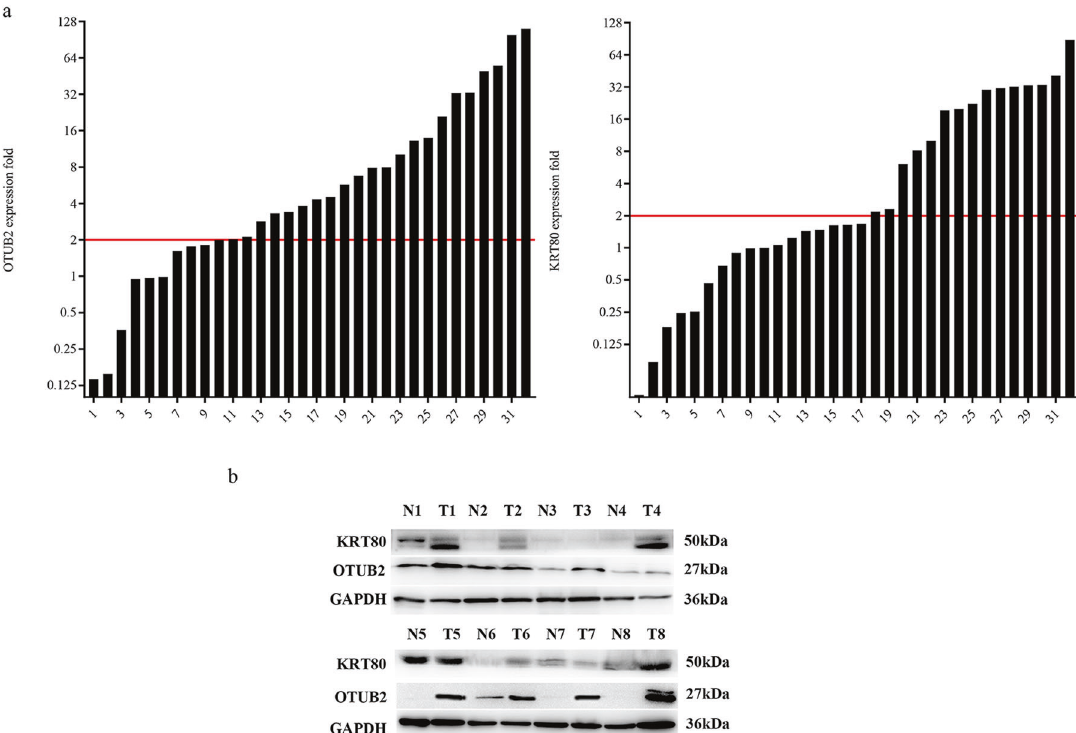
Fig. 1 OTUB2 and KRT80 are expressed in gastric cancer tissues. a Real-time PCR analysis of the expression of OTUB2 and KRT80 in 32 primary gastric cancer tissues and paired normal tissues. The levels of mRNA expression were normalized to those of β -actin. b Western blotting was used to determine the expression levels of OTUB2 and KRT80 proteins in eight representative gastric cancer specimens; “ N ” denotes adjacent normal tissue and “ T ” denotes tumor tissue. At least three separate experiments are represented by the